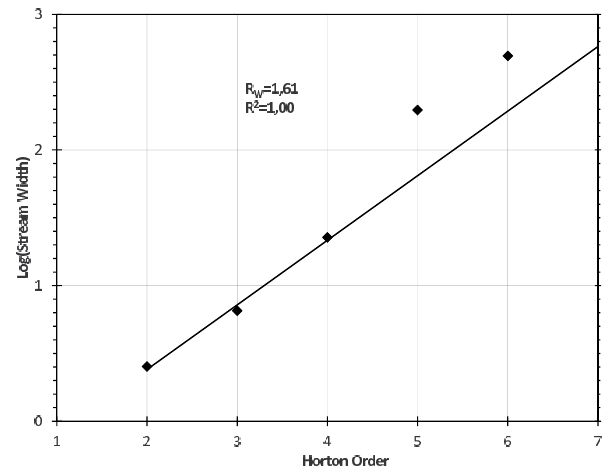
Figure 3. Horton analysis of upstream areas (including orders 2, 3, and 4) for the Ashley River basin (McKerchar et al., 1998); results kindly provided by Mantilla (2014).